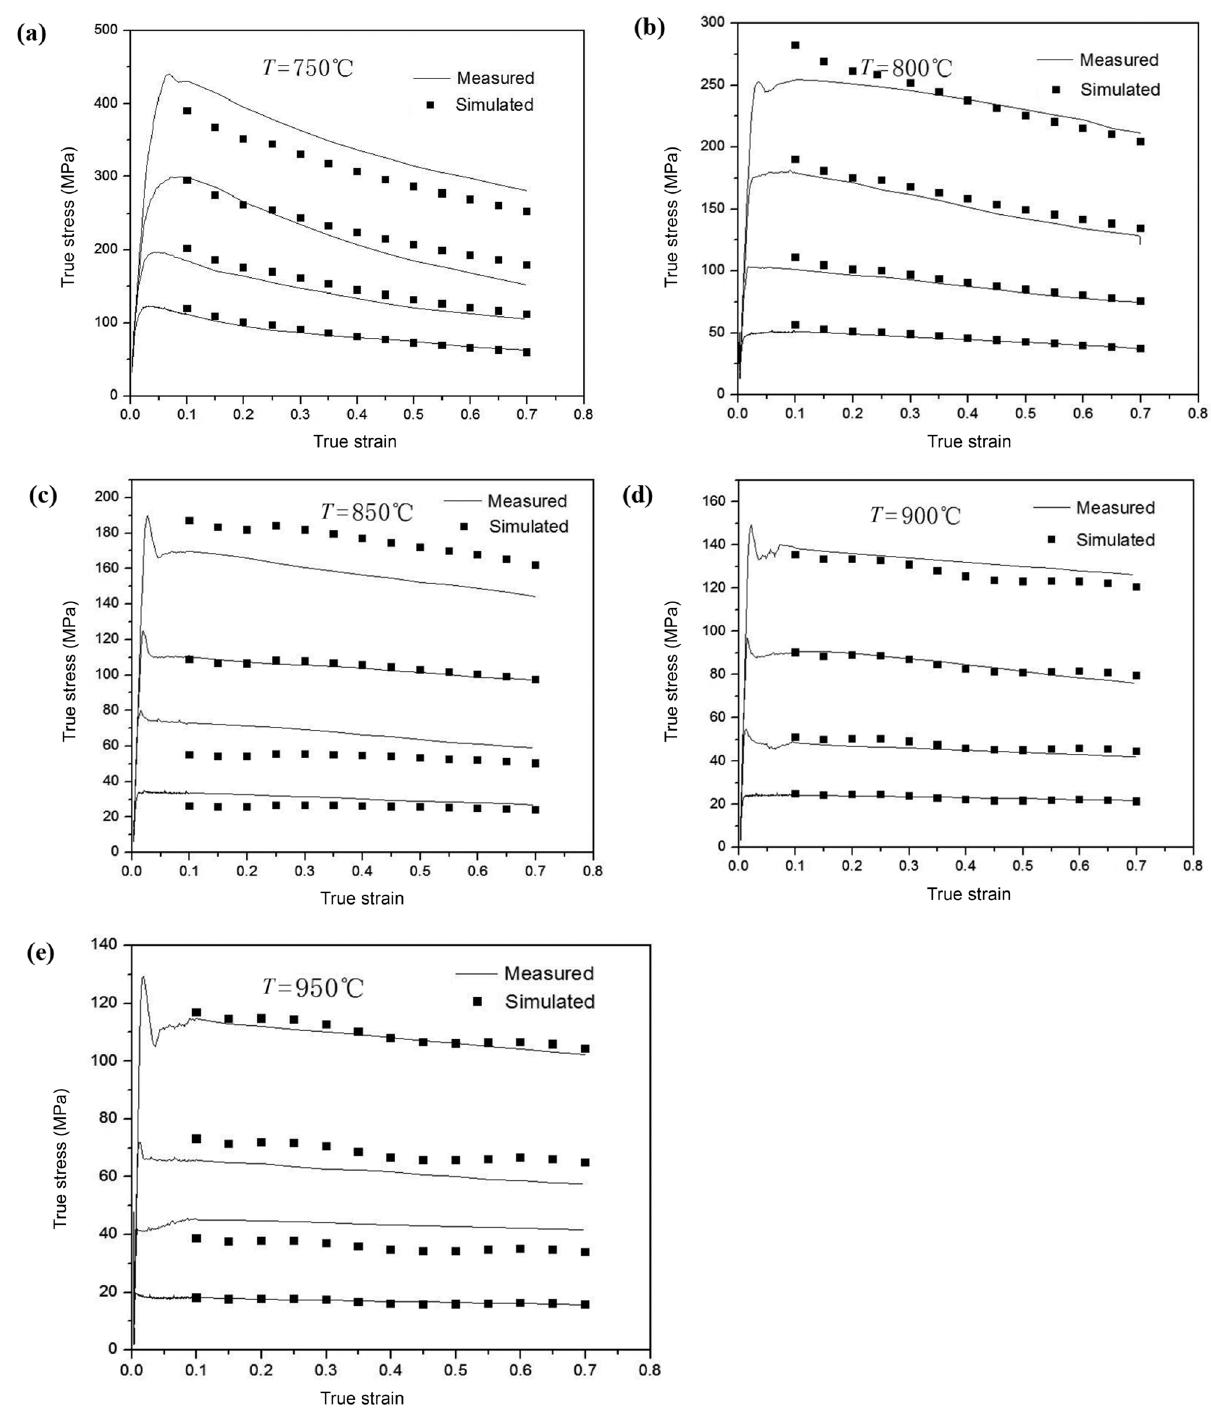
Figure 11: Comparison between the experimental and predicted flow stress at different temperatures: (a) 750°C; (b) 800°C; (c) 850°C; (d) 900°C (e)